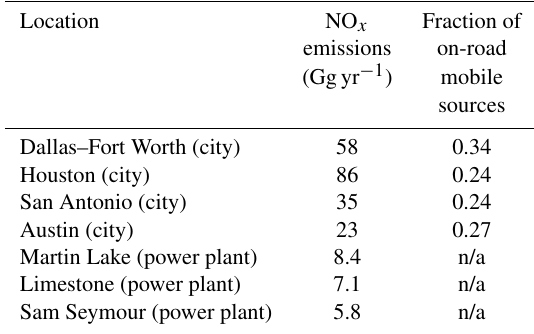
Table 1. NO x inventory emission rates for 2019 from the four largest metropolitan areas and three largest power plants within our model domain. For the cities, the fraction of emissions allocated to on-road mobile sources is also